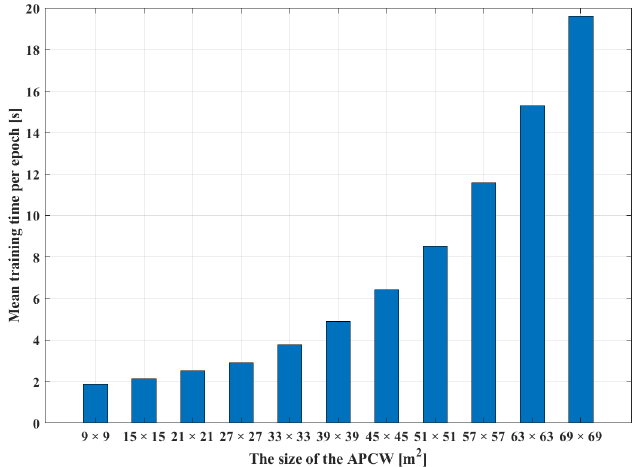
Figure 10. Mean RGN training time per epoch for varying APCW sizes.